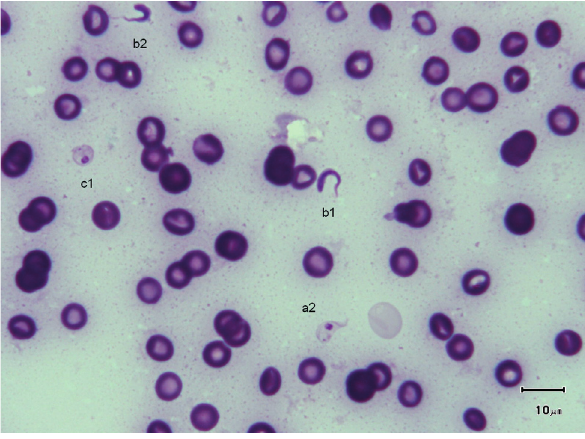
1. – Three main forms of Trypanosoma congolense forest-type in a dog: slender forms or T. (Nannomonas) isomorph ( congo- lense -form) (without free flagellum (b1), with free flagellum (b2)), stumpy form or T. (Nannomonas) hyperpachymorph (C-shape: a2) and sphaeroblast-form or T. (Nannomonas) sphaeromorph ( mon- tgomeryi -type: c1). Photo by Marc Desquesnes.